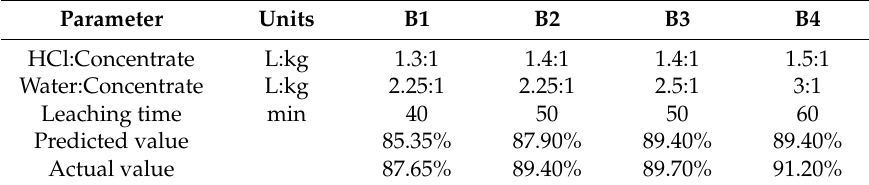
Table 5. The results of experiment checking.